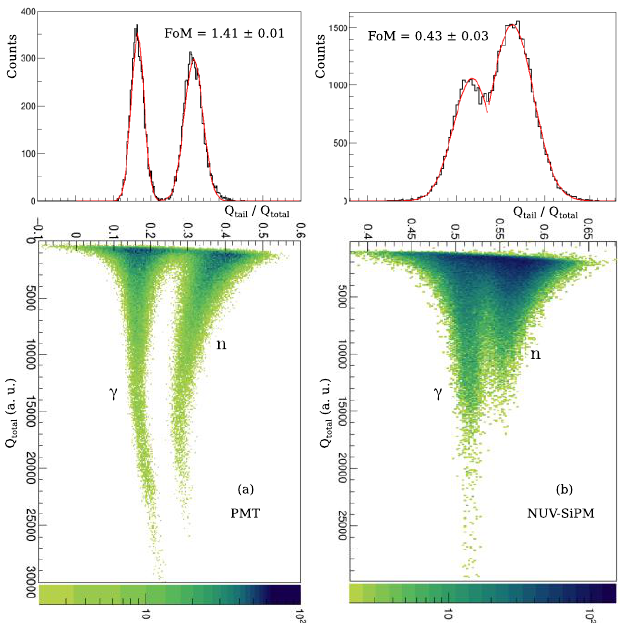
Fig. 9. 2D plots, PSP versus Q total , corresponding to the measurements using the Am-Be source with the EJ-299 (50 mm dia. x 50 mm thick.) coupled to the